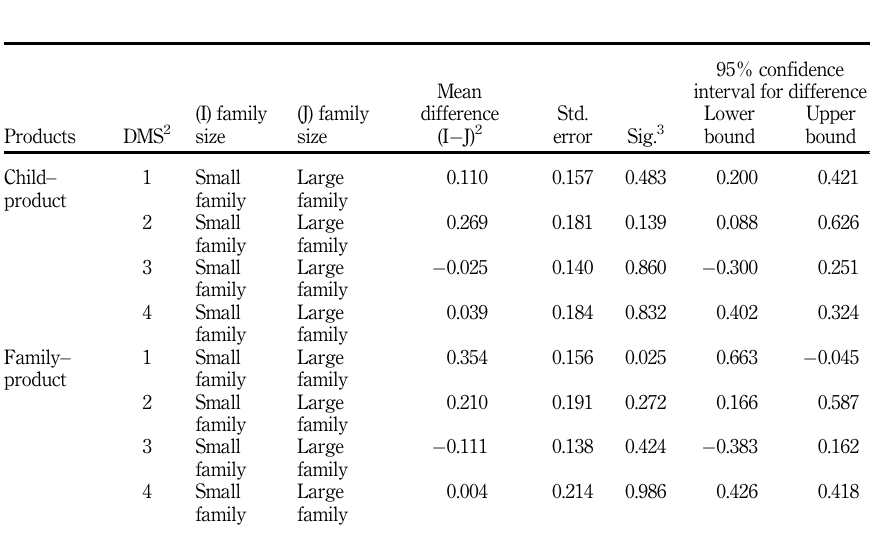
Table 8. Results relating